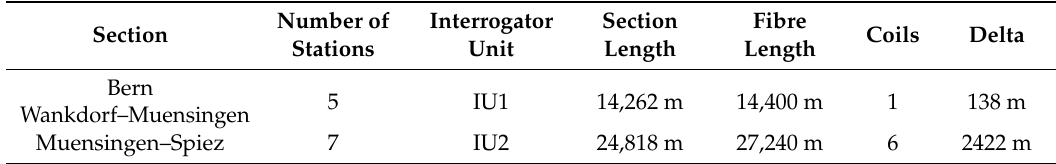
Table 1. Section and optical fibre